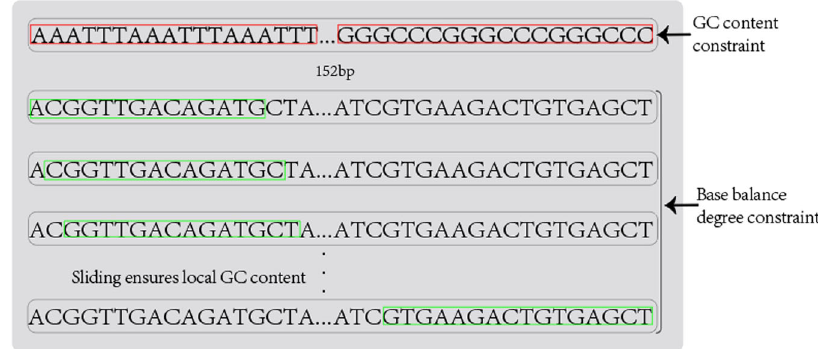
Fig. 7 The difference between base balance degree constraint and GC content